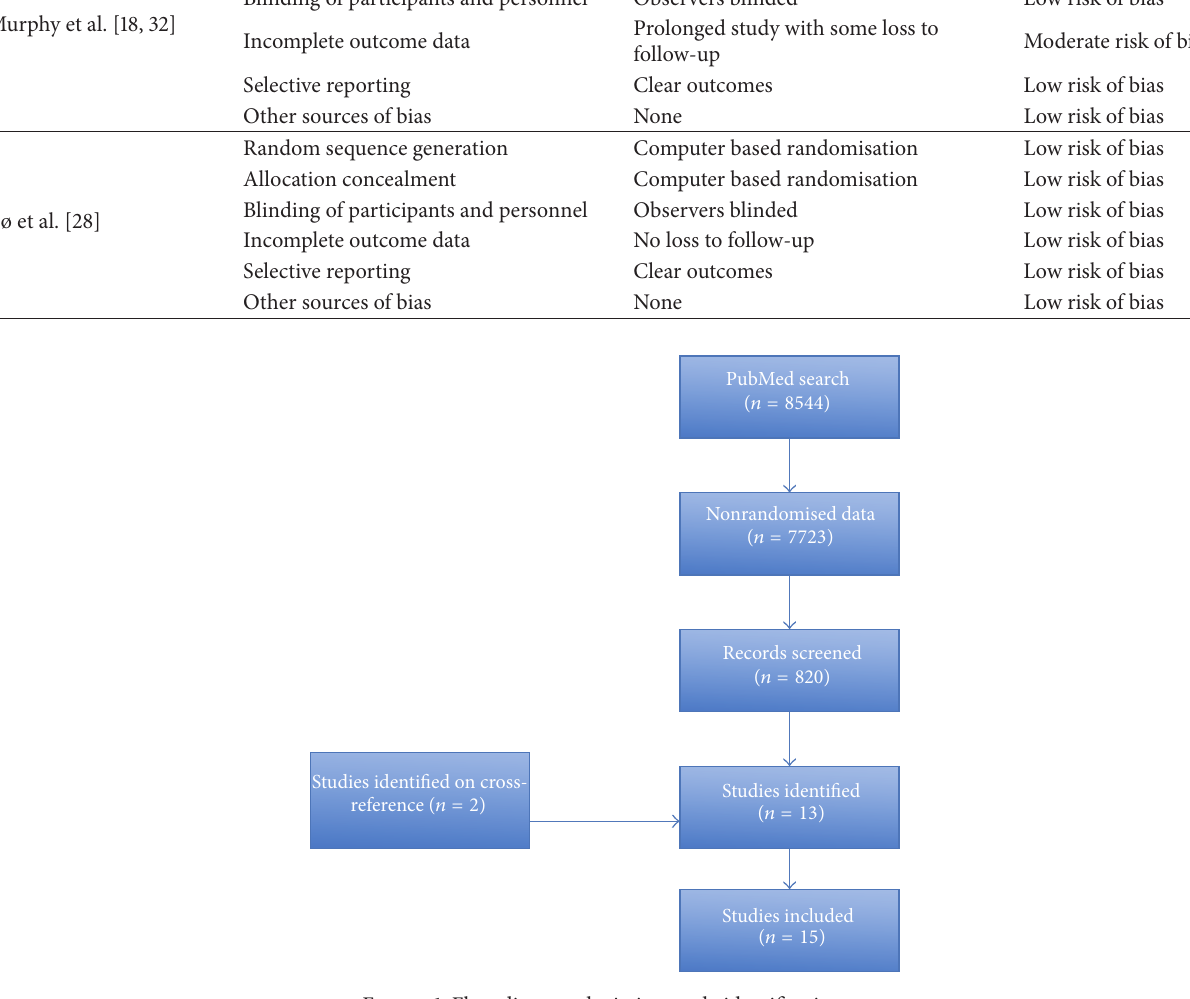
Figure 1: Flow diagram depicting study